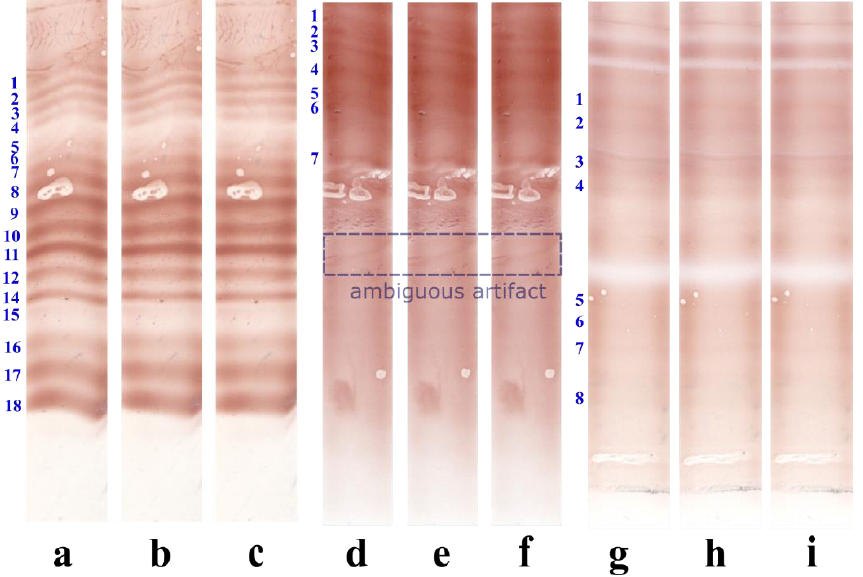
Figure 6. A comparison of band straightening with OCBSA-2016 ( b , e , h ) vs. OCBSA-2021 ( c , f , i ) on a control lane ( a – c ), a serum lane ( d – f ), and a tear lane ( g – i